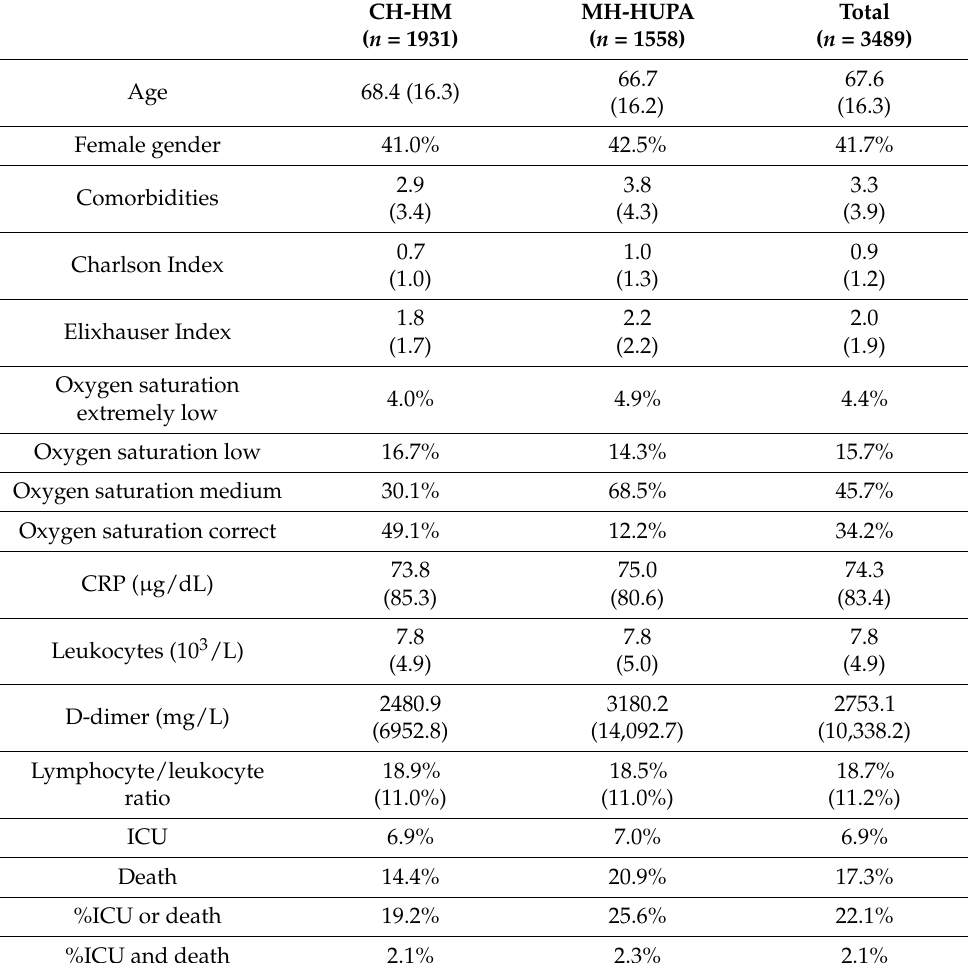
Table 2. Description of the COVID-19 patients included in the study. Results include those of the Grupo Hospitales de Madrid (CH-HM) at the central area of Madrid, and those of the Hospital Universitario Pr í ncipe de Asturias (MH-HUPA) at the metropolitan area of Madrid. We also present the results of the two cohorts together (total cohort). Global description of the patients included in the study showing the mean (standard deviation) values of the demographic, clinical, and analytical characteristics of the patients, as well as the percentage of admissions to the intensive care unit (ICU) and deaths. The results are expressed as mean (standard deviation). CRP = C-reactive protein, n =